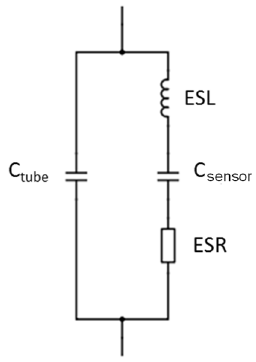
Figure 21. Sensor’s electrical model.